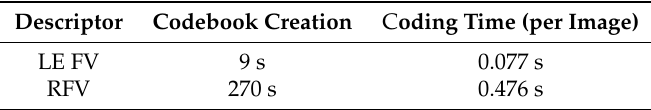
Table 9. Computation time in seconds on the VisTex